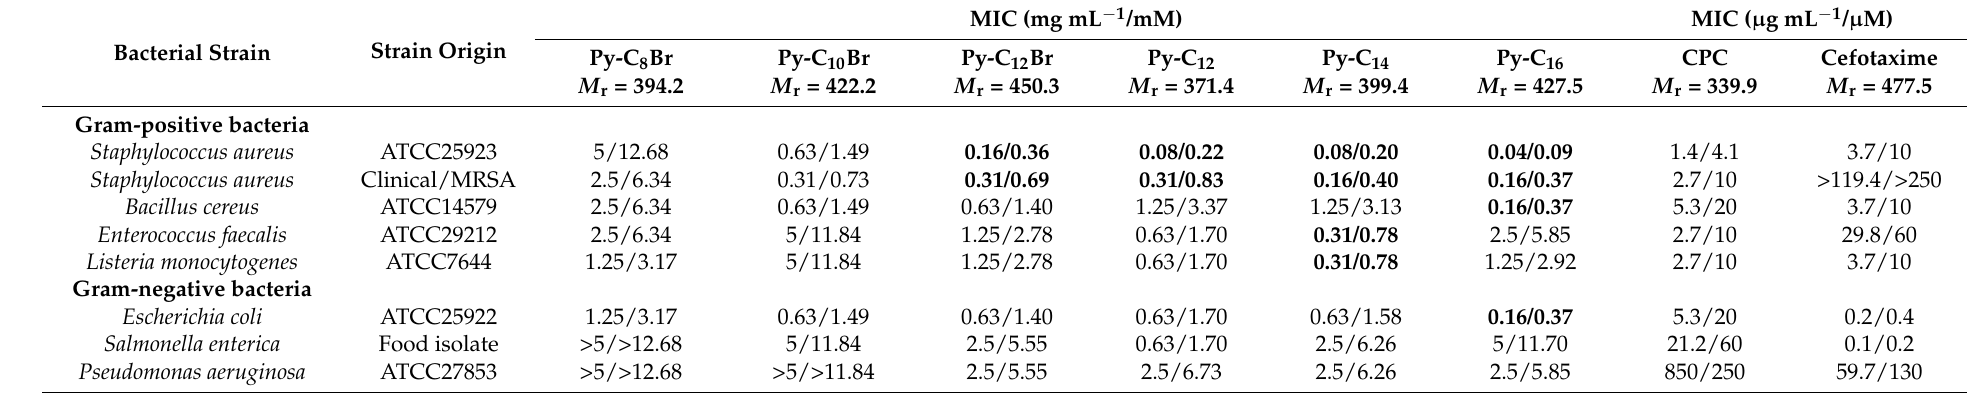
Table 2. Antibacterial activities of alkylated derivatives of pyridinium-4-aldoxime. The minimal inhibitory concentrations (MIC) are expressed in mg mL − 1 /mM and µ g mL − 1 / µ M. MIC is the highest concentration of the compound required to suppress bacterial growth in three replicate